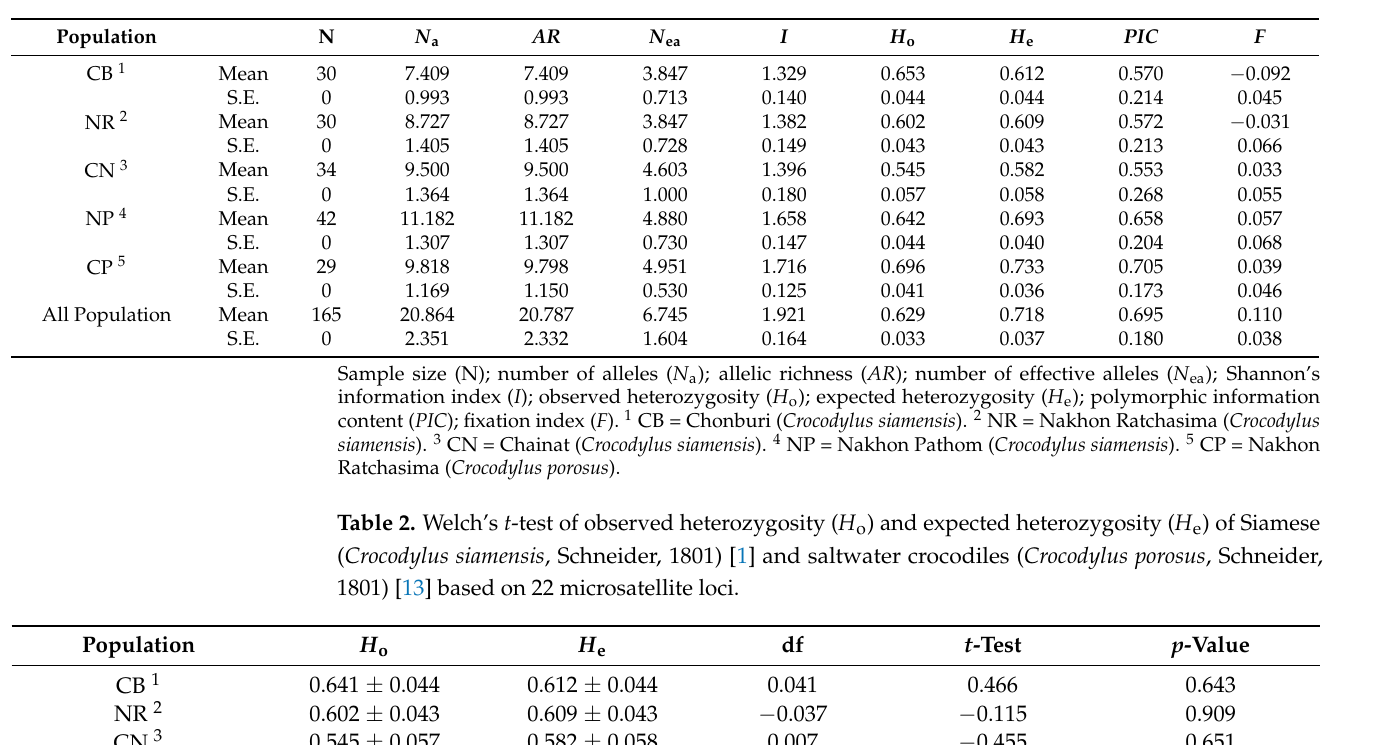
Table 1. Genetic diversity of 136 Siamese ( Crocodylus siamensis , Schneider, 1801) [1] and 29 saltwater crocodiles ( C. porosus , Schneider, 1801) [13] based on 22 microsatellite loci. Table S1 provides detailed information on the sampled individuals.